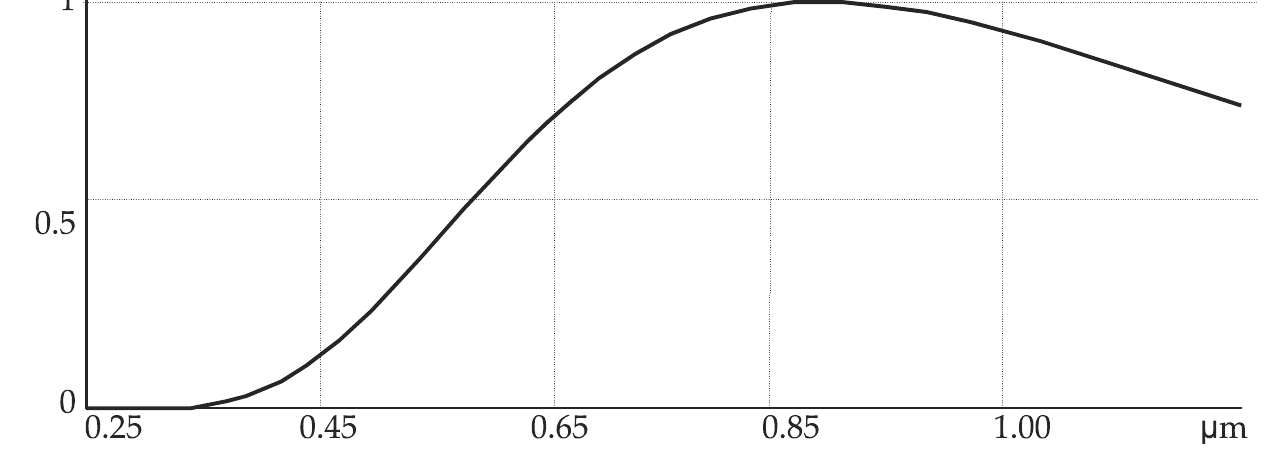
Figure 8. The curve of the relative spectral intensity of a halogen lamp.